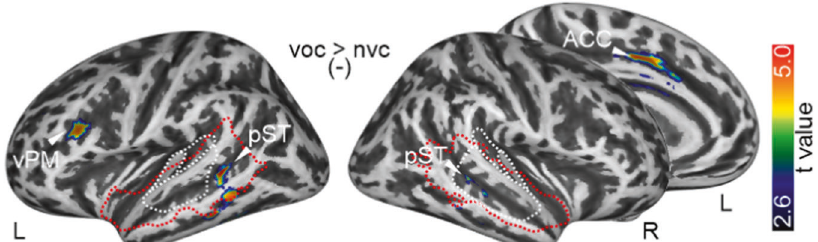
Fig. 4 Neural voice processing depending on autistic traits. Increased cortical activity (left panels) for voice compared to non-voice sounds with decreasing levels of the AQ score ( n =